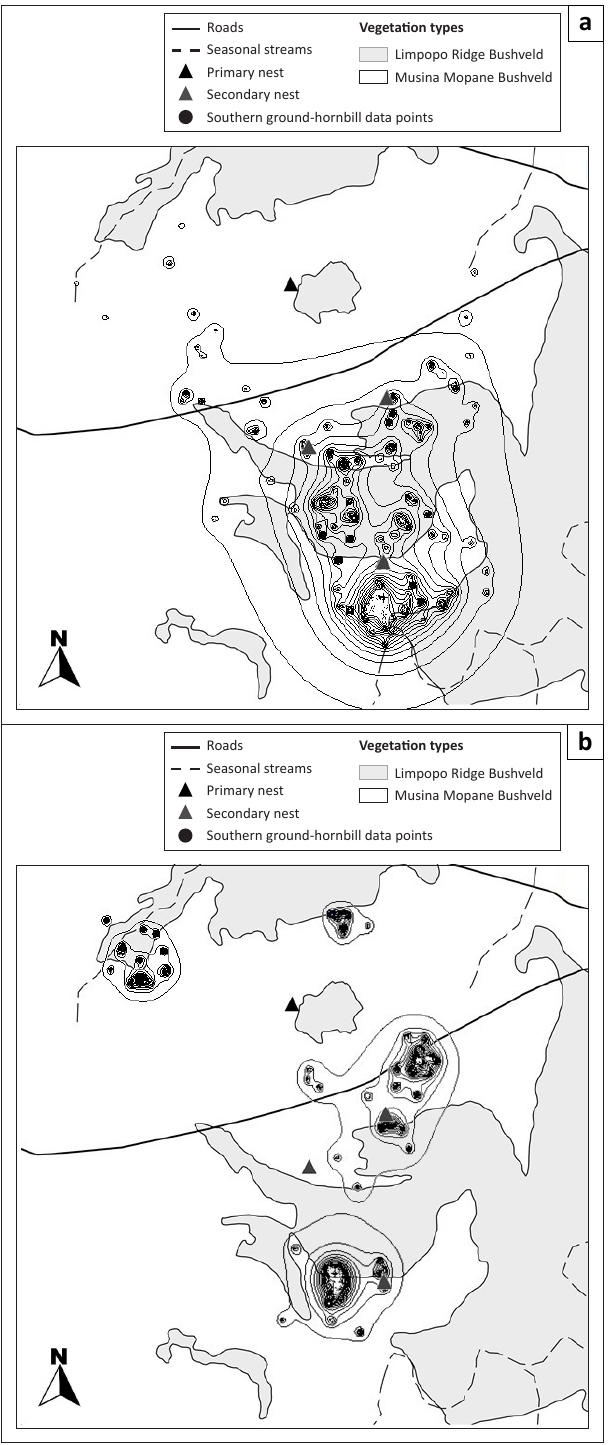
FIGURE 4: The (a) summer and (b) winter seasonal kernel home ranges of a Southern ground-hornbill group during the study period in relation to environmental features. Contour lines indicate kernel mean analyses using 95 % fixes at 5 %